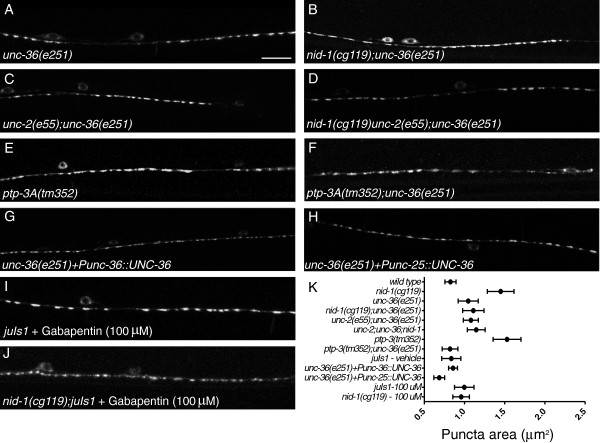
unc-36 regulates presynaptic morphology. (A, B) unc-36 mutants also had slightly enlarged puncta, and also suppressed the defects in nid-1. (C) unc-2;unc-36 mutants appeared similar to the single mutants, but were not further enlarged. (D) Suppression of nid-1 was not enhanced by simultaneous loss of both unc-2 and unc-36. (E) A deletion in the ptp-3A specific coding region, tm352, causes a nid-1 like defect in synapses, which is also suppressed by loss of unc-36 (F). (G) Broadly replacing UNC-36 function via transgene efficiently rescued the enlarged puncta found in unc-36(e251) mutants. (H) Specific expression of UNC-36 solely in the D-type motor neurons was also sufficient to reduce the puncta enlargement found in unc-36(e251). (I, J) Treatment of wild type animals (I) or nid-1(cg119) (J) with the α2/δ-subunit antagonist, gabapentin, resulted in enlarged puncta similar to those found in e251. (K) The puncta area by genotype are plotted as the mean (circle) with 5 to 95% confidence interval (whiskers). All animals in these micrographs are young adults (1 to 2 days post 4th larval stage (L4)).